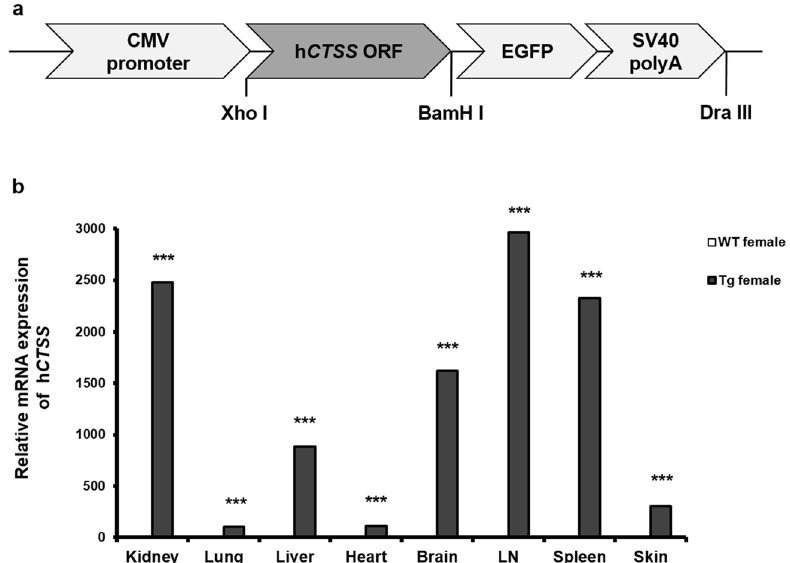
Figure 1. Cathepsin S (CTSS) overexpression vector construction and transgene expression in various tissues. ( a ) Schematic diagram of transgene vector construction for generation of CTSS-overexpressing TG mice. A cytomegalovirus (CMV) promoter was used to overexpress CTSS in all organs. EGFP enhanced green fluorescent protein, ORF open reading frame. ( b ) Human CTSS mRNA expression in various organs of 10-week-old WT and TG female mice measured by qRT-PCR. TG transgenic, WT wild type, LN lymph node. *** p < 0.001 versus untreated WT